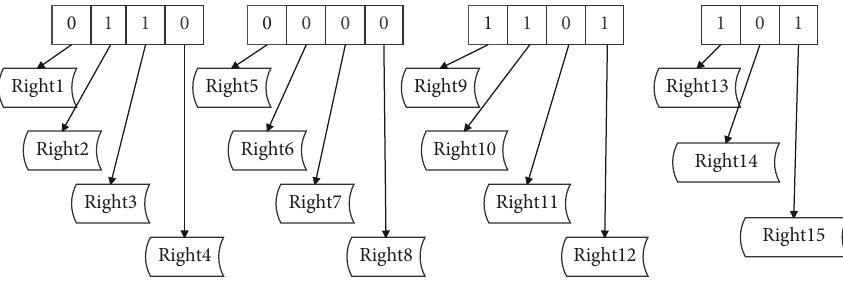
Figure 7: Permission logic ruler.